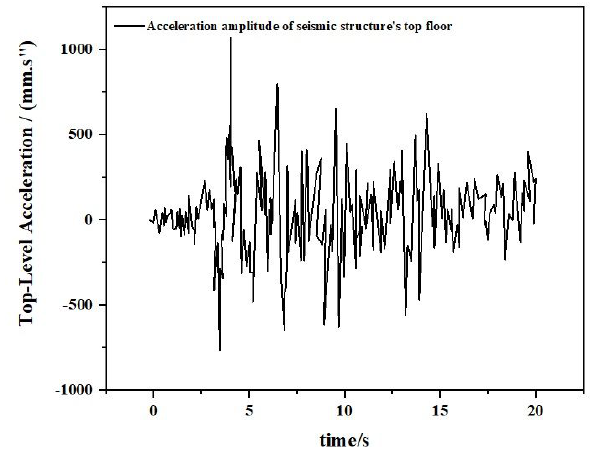
Figure 4: Top level acceleration in frequent earthquakes